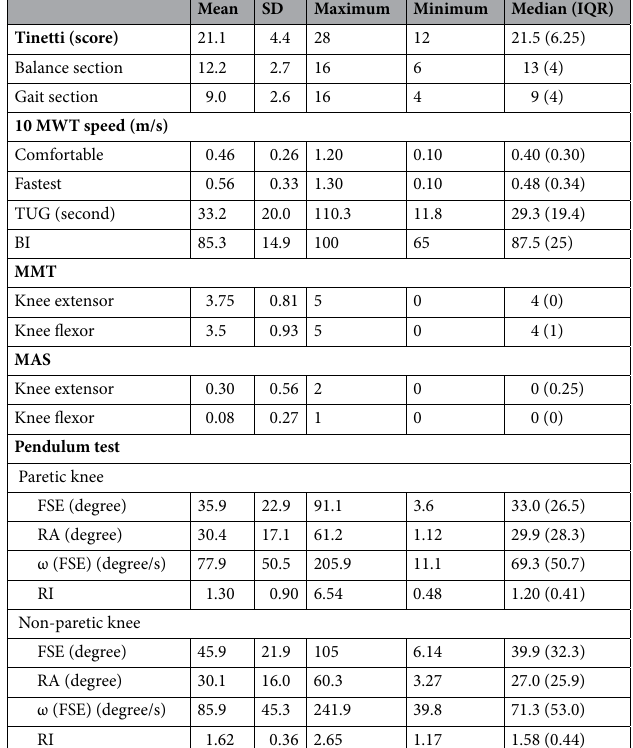
Table 2. Clinical assessment, MAS, and the pendulum parameters. a Data are presented as mean, standard deviation (SD), maximal, minimal, and interquartile range (IQR) values. § 10 MWT 10-m walk test; TUG timed-up-and-go test; BI Barthel index; MMT manual muscle test; MAS modified Ashworth scale; FSE first swing excursion; ω(FSE) angular velocity of the first swing excursion; RA resting angle of the pendulum test; RI relaxation